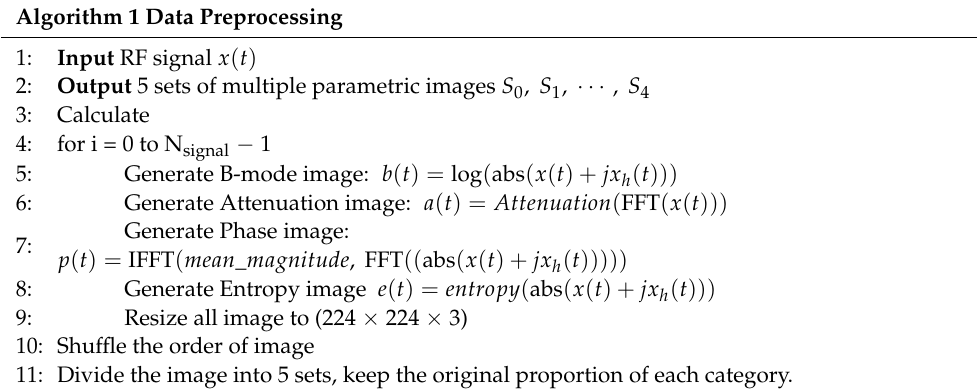
Algorithm 1 Data